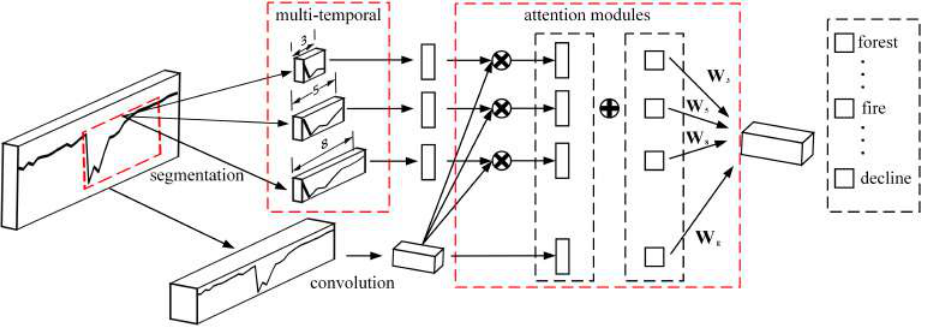
Figure 5. Flowchart of the multitemporal CNN